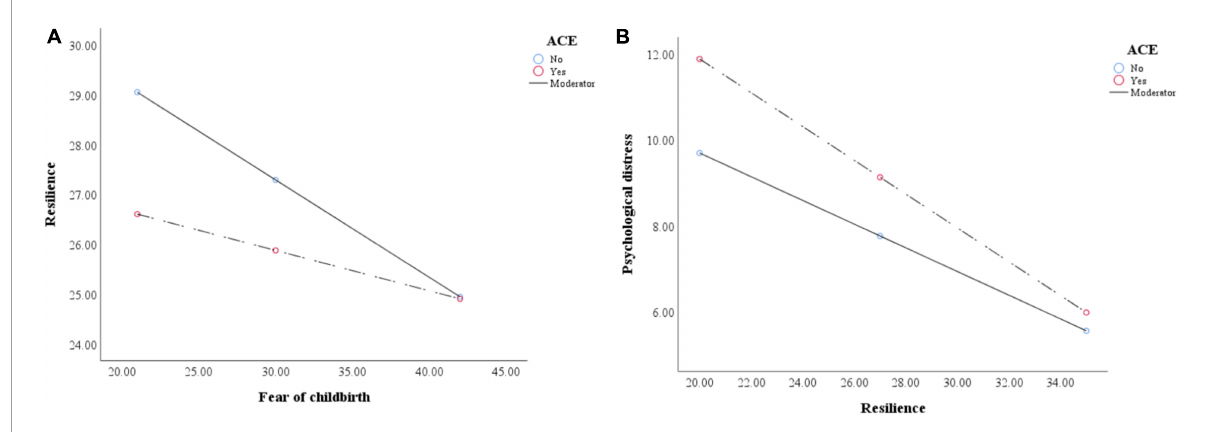
FIGURE4 (A) The interaction between fear of childbirth and ace on resilience. (B) The interaction between resilience and ace on psychological